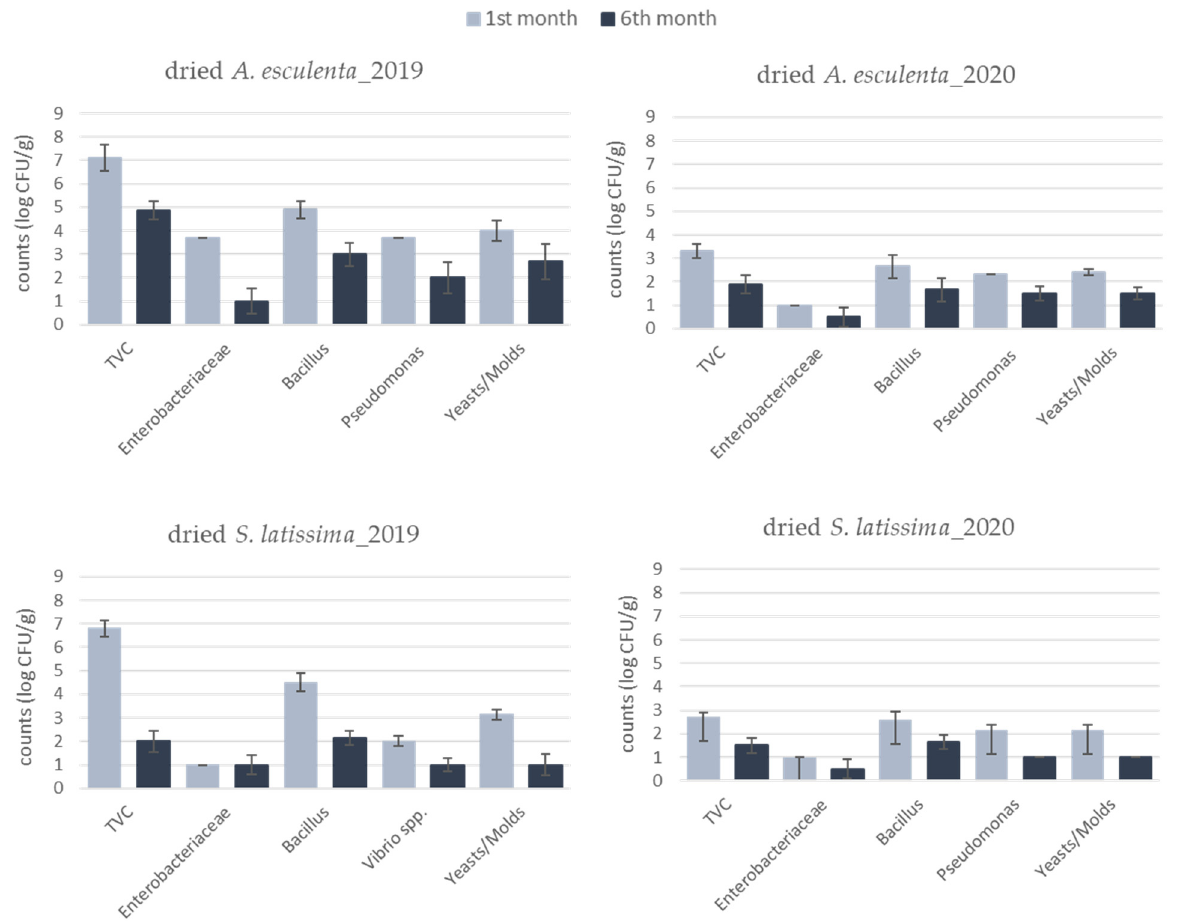
Figure 4. Microbiological profile of dried seaweeds A. esculenta and S. latissima harvested in 2019 and 2020, after 1 and 6 months of storage at 22 °C.